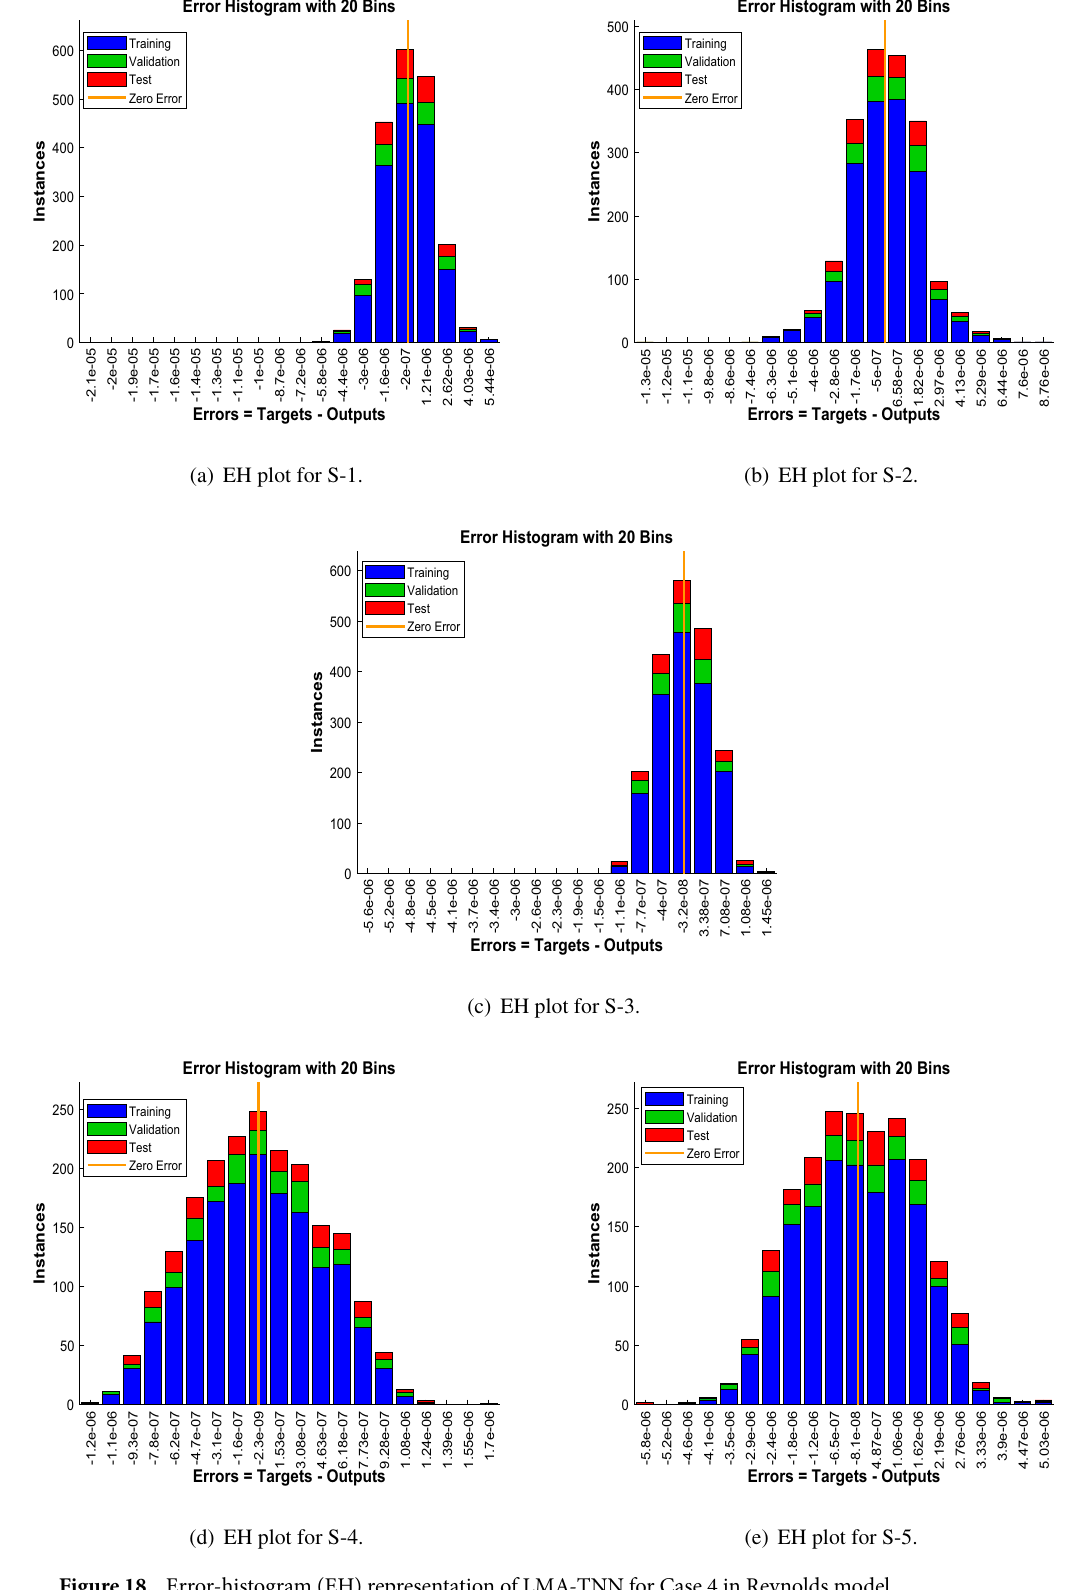
(d) EH plot for S-4. (e) EH plot for S-5. Figure 18. Error-histogram (EH) representation of LMA-TNN for Case 4 in Reynolds